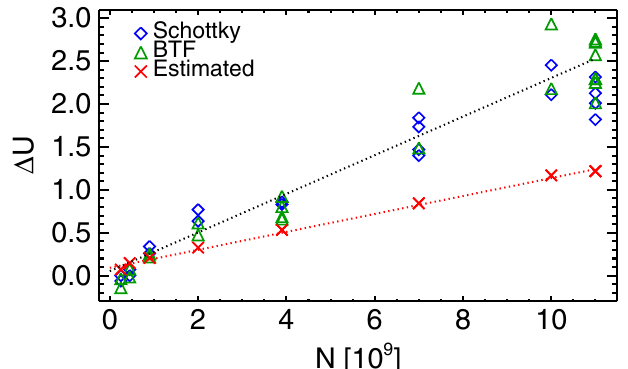
FIG. 6. (Color) Comparison of the space-charge parameters (cid:1) U sc obtained from Schottky (blue diamonds) and BTF (green triangles) measurements, and estimated from the beam parame- ters (red crosses) versus ion number. Least mean square fits to the estimated and measured points are shown, too.